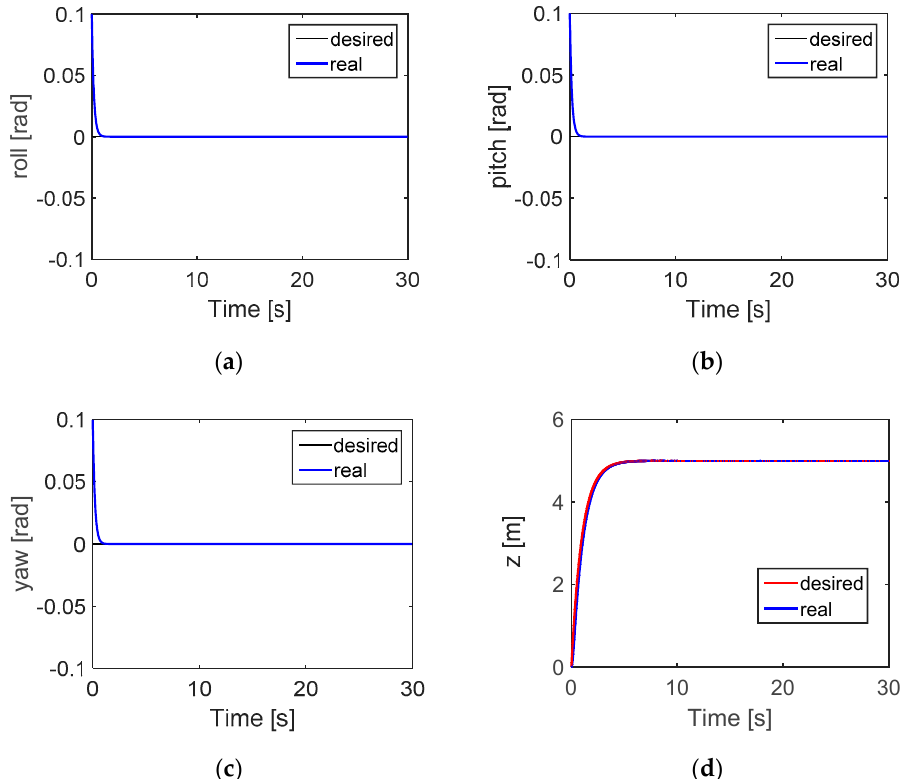
Figure 3. Trajectory performance in fault-free case: ( a ) Roll angle, ( b ) Pitch angle, ( c ) Yaw angle, ( d ) and z-direction.